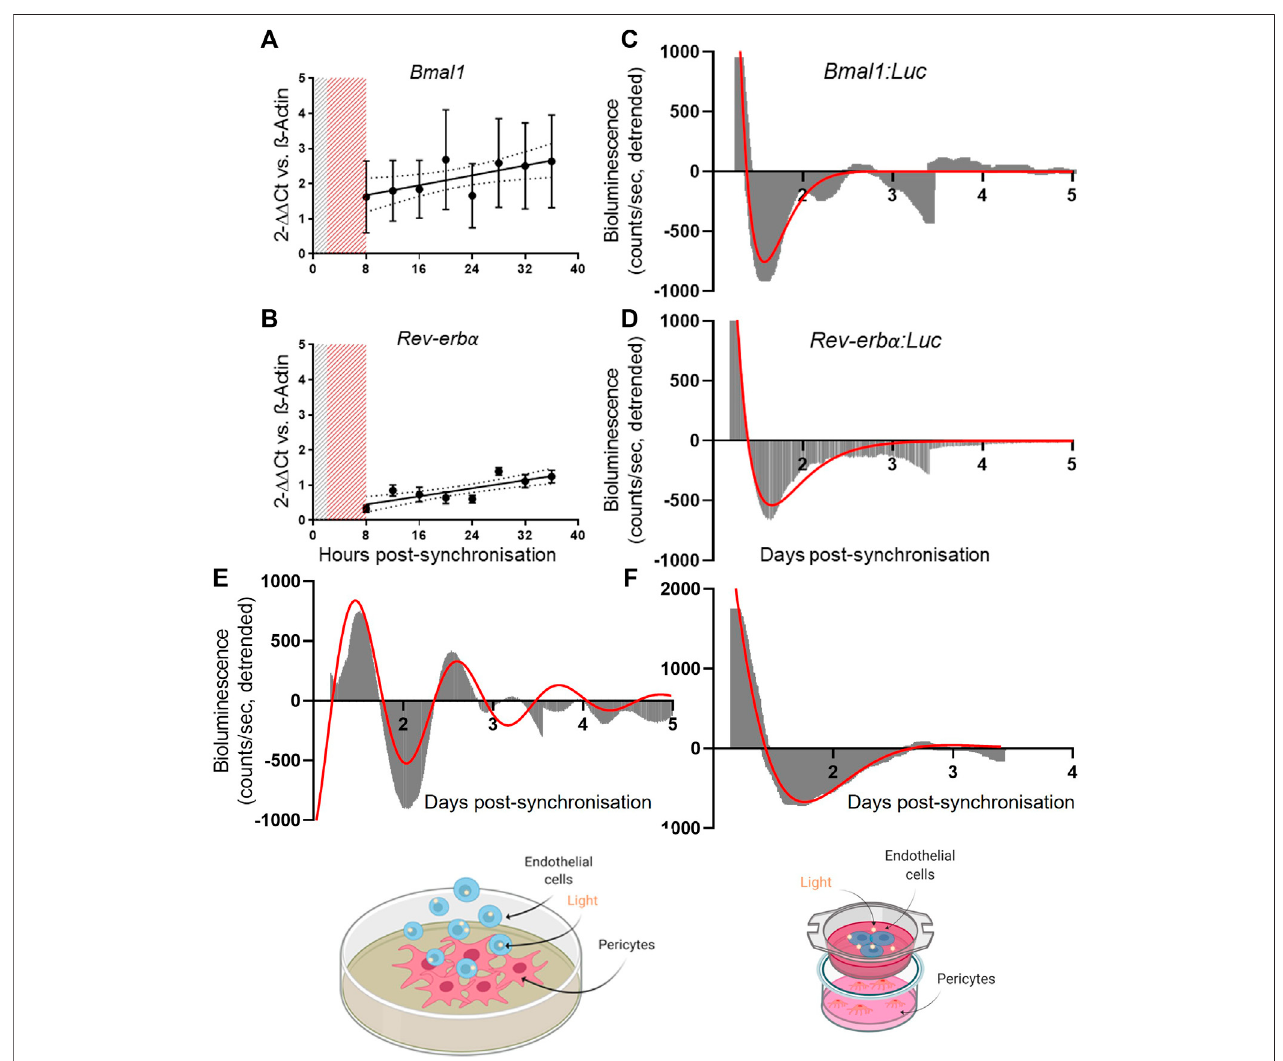
FIGURE 2 | Pericytes ’ clock synchronization in fl uences endothelial cells ’ Bmal1 rhythmicity. mRNA expression of Bmal1 (N = 3, (A) ) and Rev-erb α (N = 3, (B) ) in humanumbilicalveinendothelialcells(HUVEC).Thedataareshownas2 − ΔΔ Ct andnormalizedon β -actinhousekeepingmRNAexpression.ErrorbarsrepresentSEMand 95% CI is shown in the graph. Non-linear regression (Cosinor Curve) was compared against straight line; straight line is the preferred model (p > 0.05). Average detrended non-oscillatory pro fi le ofserum shock synchronized HUVEC cellstransduced withBmal1:Luc (N =2, (C) ) or Rev-erb α :Luc(N =2, (D) ) lentivectors. Data are shown in area graphs and counts/sec are plotted against days post-synchronization. Red line represents a damped sin wave with a period of 24 h. Average detrended oscillatory pro fi le of Bmal1:Luc in HUVEC cells in a contact (N = 3, (E) ) and non-contact (N = 3, (F) ) co-culture with synchronized saphenous vein pericytes (SVP) Image shows a schematic of the protocol. Red line represents a damped sin wave with a period of 24 h.